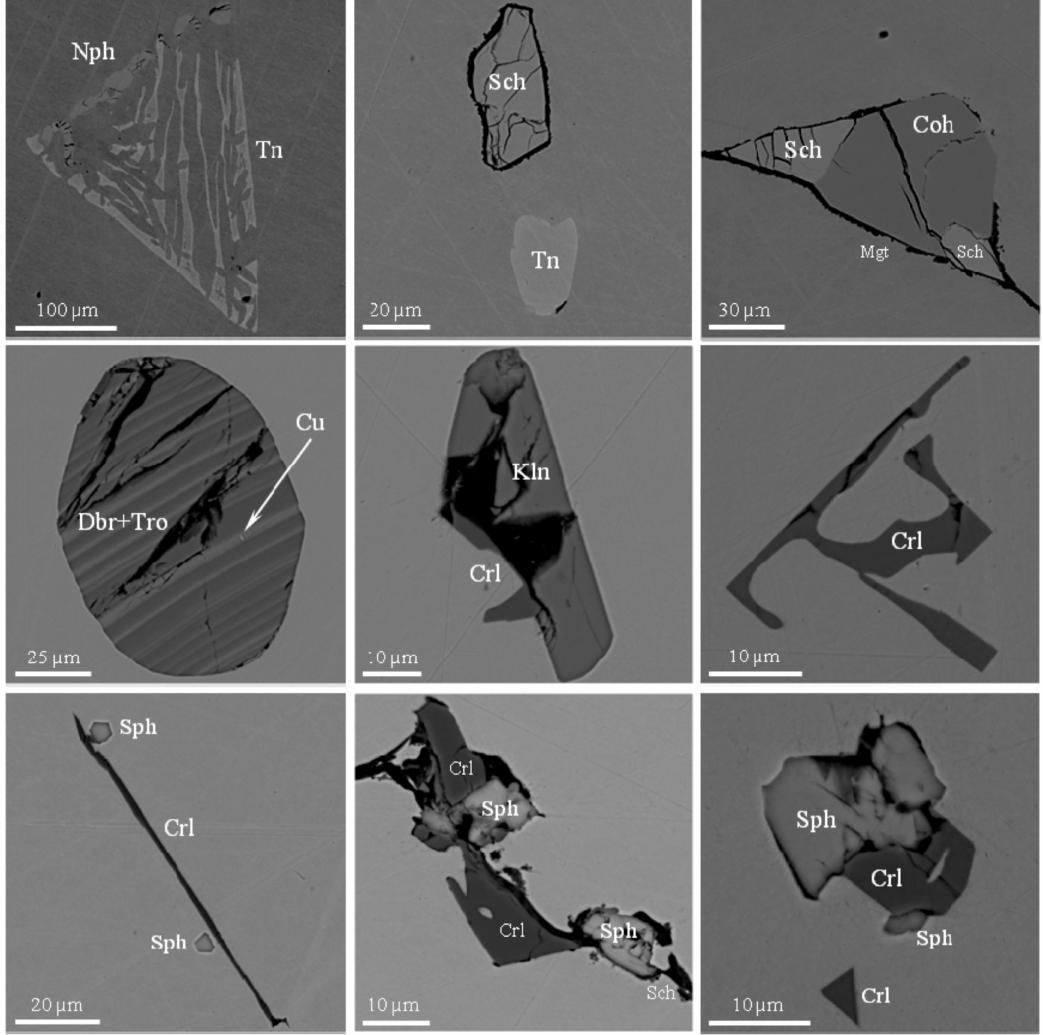
Figure 3. Mono- and polymineralic inclusions and globules in Fe-Ni-metal (kamacite), Uakit meteorite (IIAB), BSE images. Symbols: Dbr—daubr é elite; Sch—schreibersite; Nph—nickelphosphide; Tn—taenite; Coh—cohenite; Tro—troilite; Cu—native copper; Crl—carlsbergite; Kln—kalininite; Sph—sphalerite;